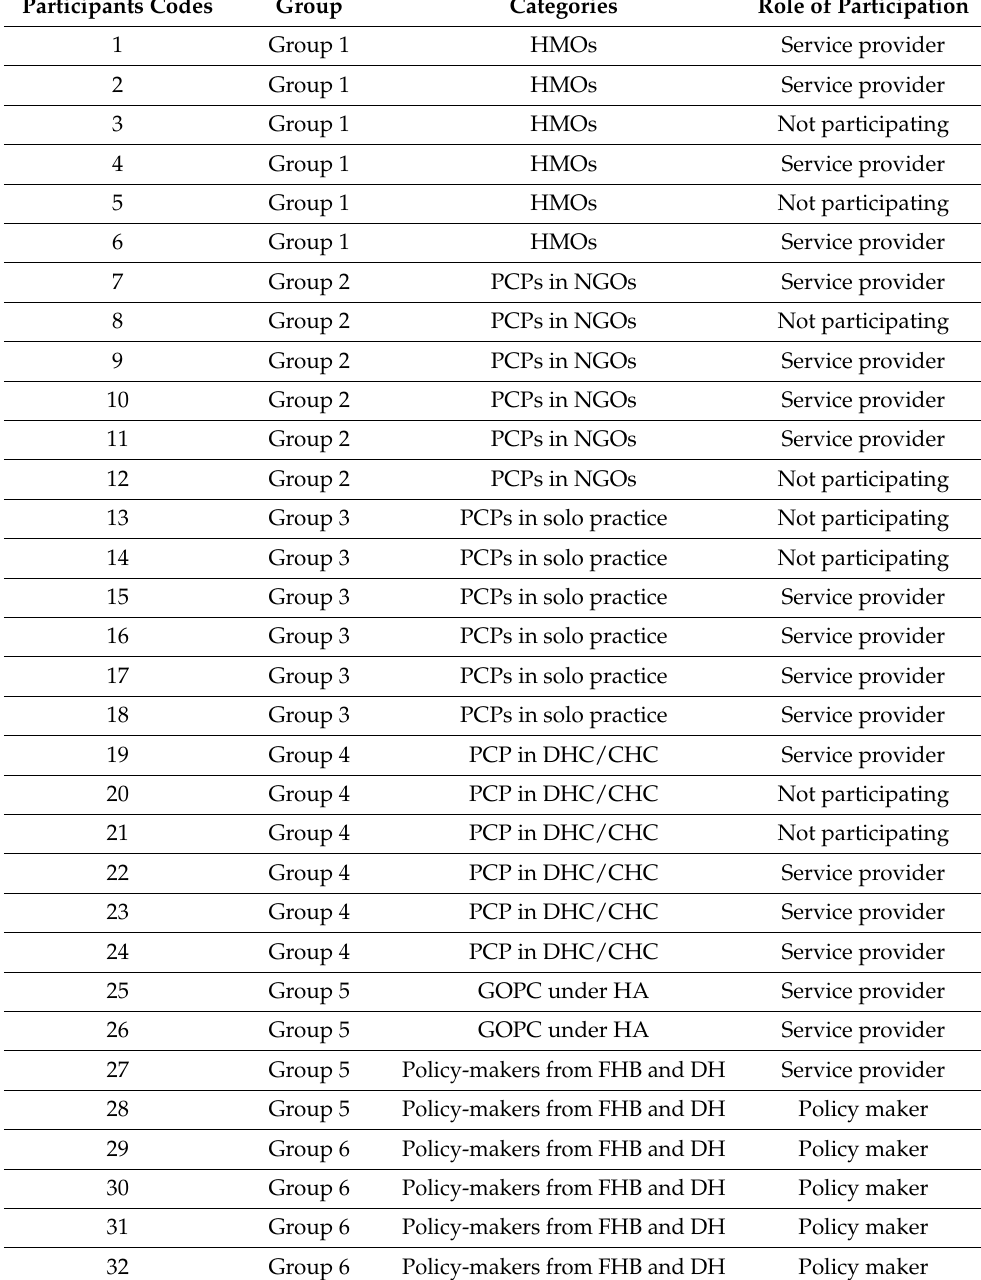
Table 1. General characteristics of physicians and